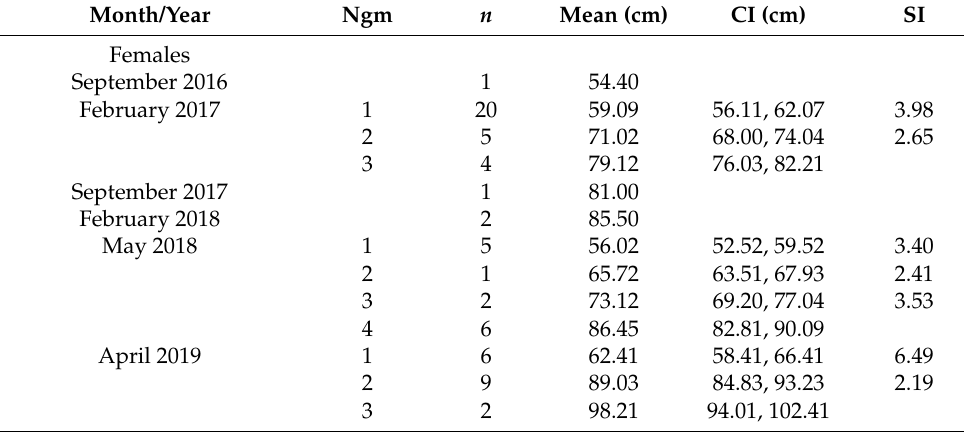
Table 2. Modes identified in the total length frequency distributions in females, males, and combined sexes of the bonnethead shark ( Sphyrna tiburo ) in the western Gulf of